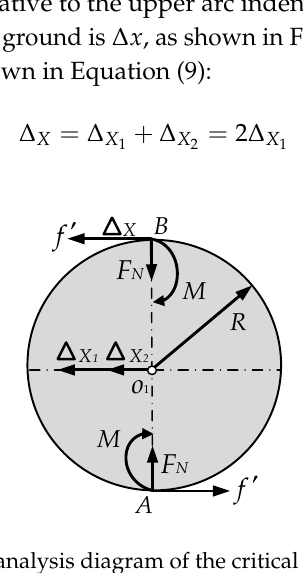
Figure 7. Force analysis diagram of the critical rolling steel ball.